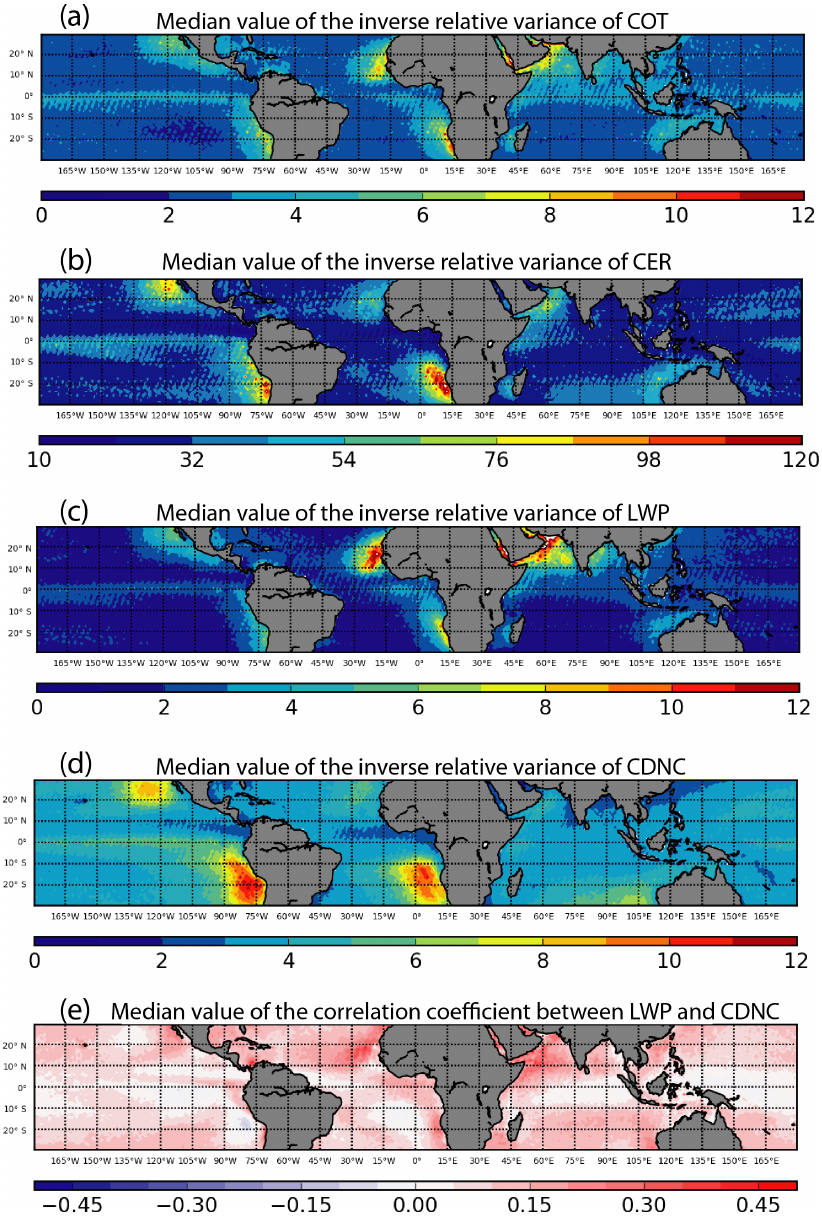
Figure 5. Median value of the inverse relative variance (i.e., v = (cid:104) x (cid:105) 2 / Var (x) ) for (a) COT, (b) CER, (c) LWP, and (d) CDNC and (e) median value of the correlation coefficient between LWP and CDNC derived from 10 years of MODIS observations. Note that the color scale of CER is different from